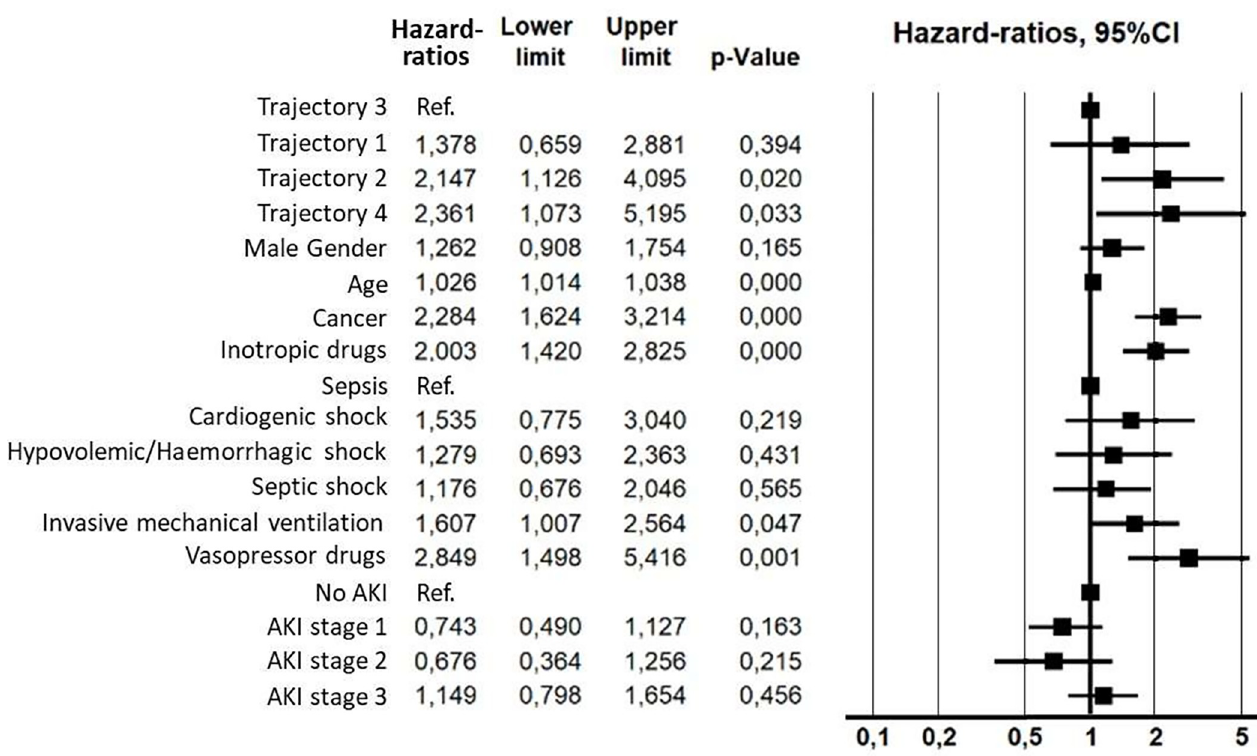
Fig 3. Factors associated with mortality (multivariable analysis). AKI: Acute Kidney